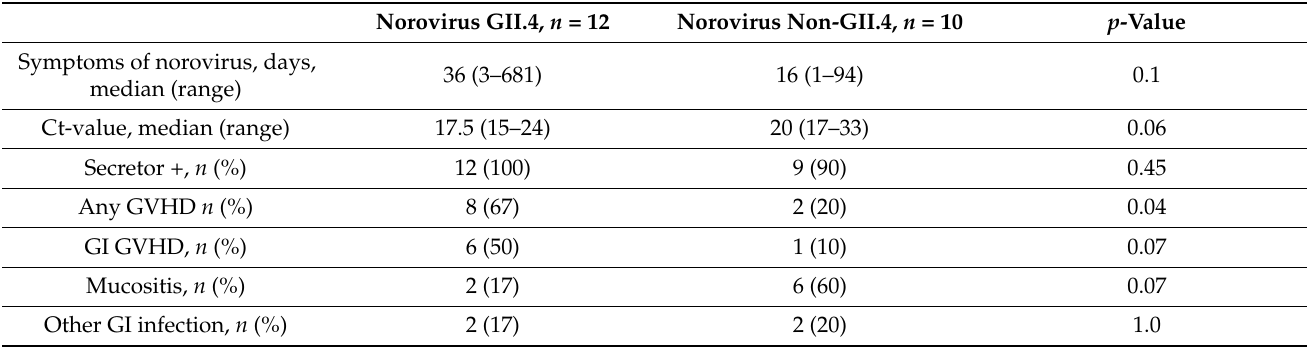
Table 2. Clinical details of patients with norovirus GII.4 and non-GII.4.